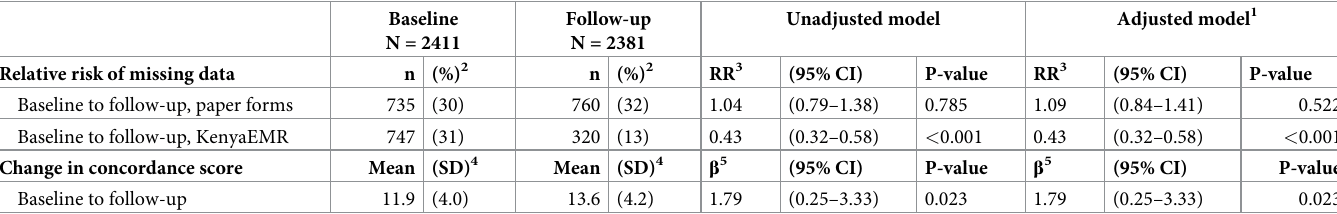
Table 4. The relative risk of missing data and mean change in concordance score from the baseline to the follow-up